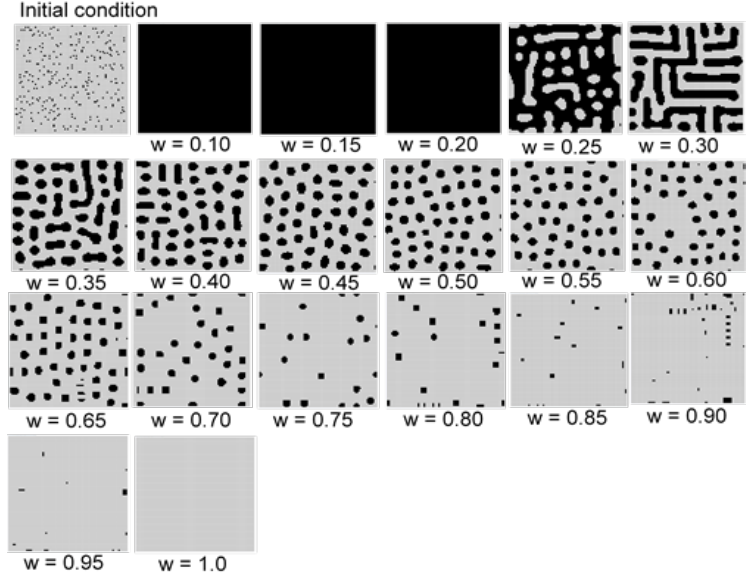
Figure 5. Results for the model of Expression (1) with s = 5 and t = 9 in a square grid. As the initial condition, 300 state 1 cells were set randomly in the calculation field. Turing-like patterns emerged as parameter w changed. When w was greater than 0.4, spot patterns were observed, whereas at w = 0.3, stripe patterns emerged. When w was 0.20 or lower, all cells in the field had a value of 1 (shown in black).